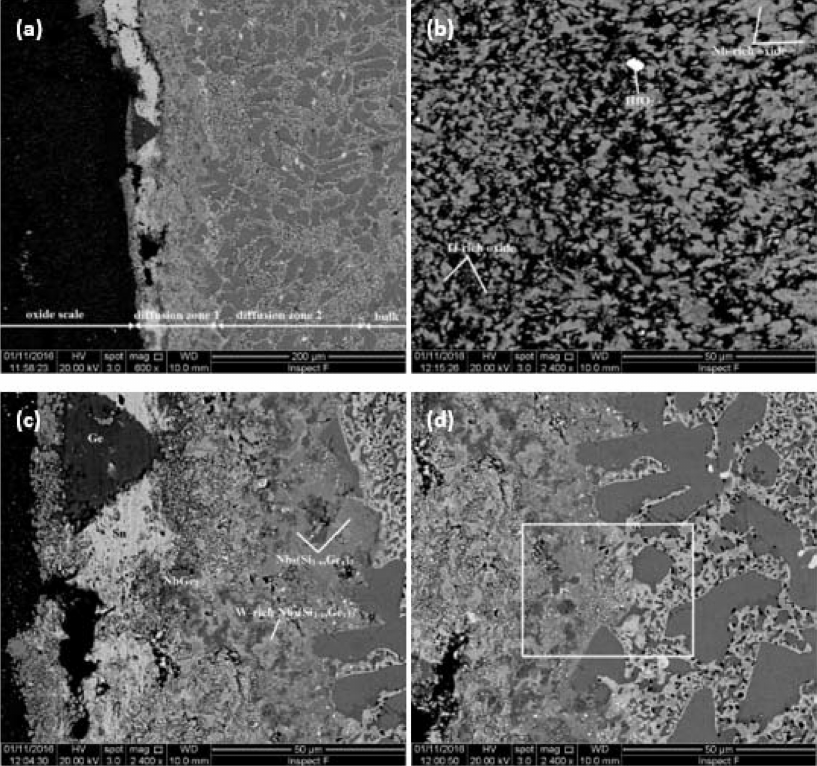
Figure 8. BSE images of the microstructure ( a ) of a cross section of the oxidized alloy JZ2, ( b ) of the oxide scale, ( c , d ) of the di ff usion zones 1 and 2, respectively. For the region indicated by a rectangle in ( d ), see later on the Figure 10 and